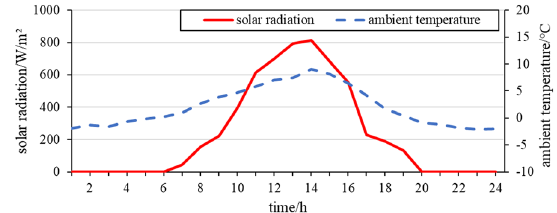
Fig. 9 Typical average daily solar radiation and ambient temperature in winter